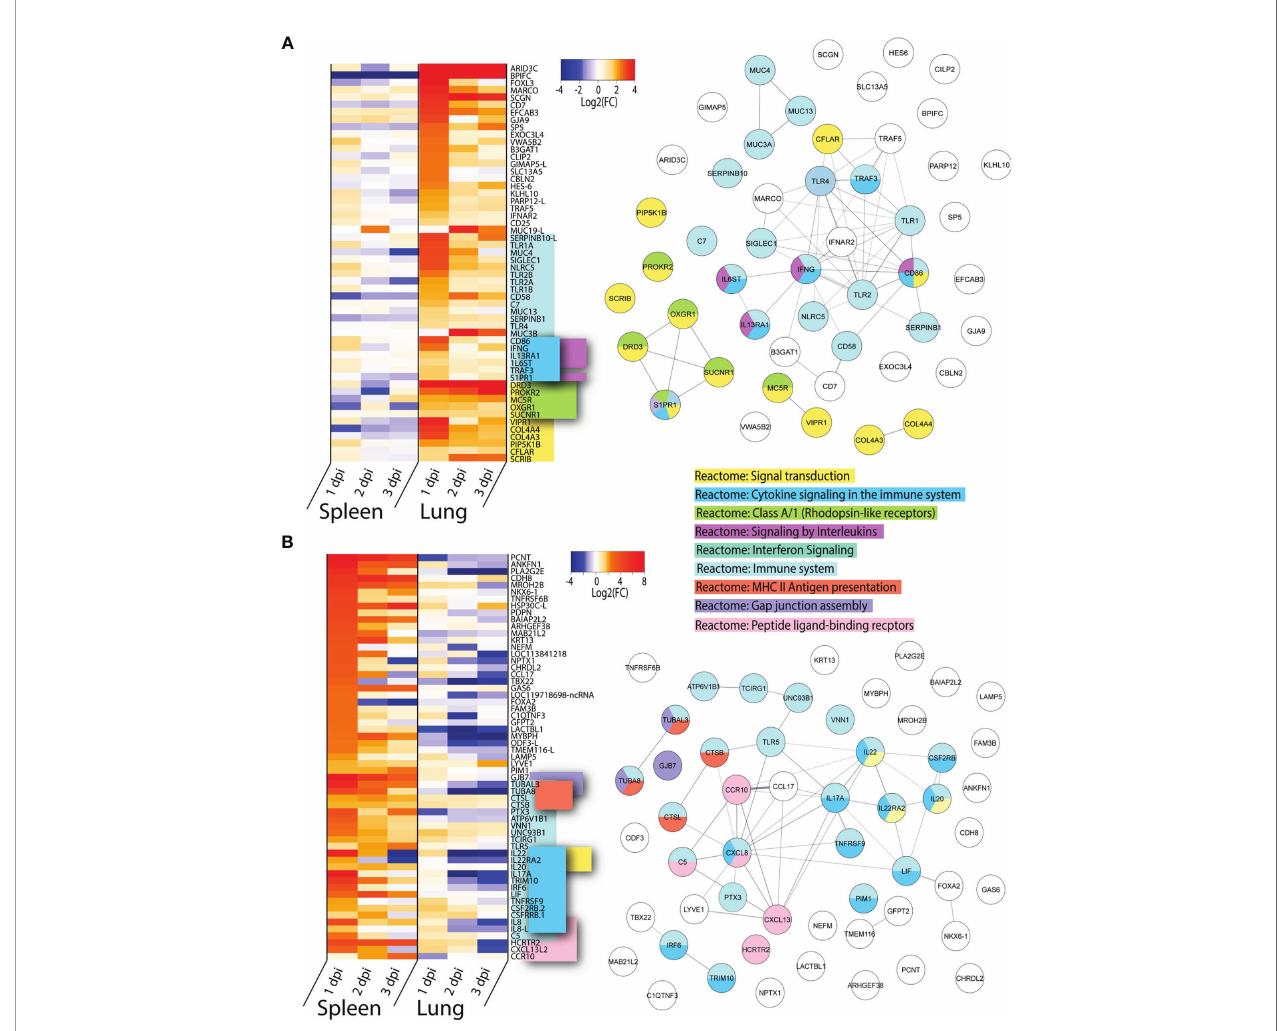
FIGURE 5 | Genes uniquely upregulated in lungs or spleens of VN1203 infected ducks. Lists of statistically signi fi cant (FDR<0.05) genes were compared for similarity in expression (Log2(FC)>1.5) and clustered together if they were uniquely upregulated in (A) lungs of VN1203 infected or (B) spleens of VN1203 infected ducks. STRING diagrams depict predicted protein-protein interactions between the products of each gene, while colour coding is based on term enrichment of Reactome pathways. No colour means that the genes did not enrich any of the Reactome terms. Reactome terms were considered signi fi cant if FDR<0.05. Enrichment and STRING diagram was created using the STRINGTIE app in